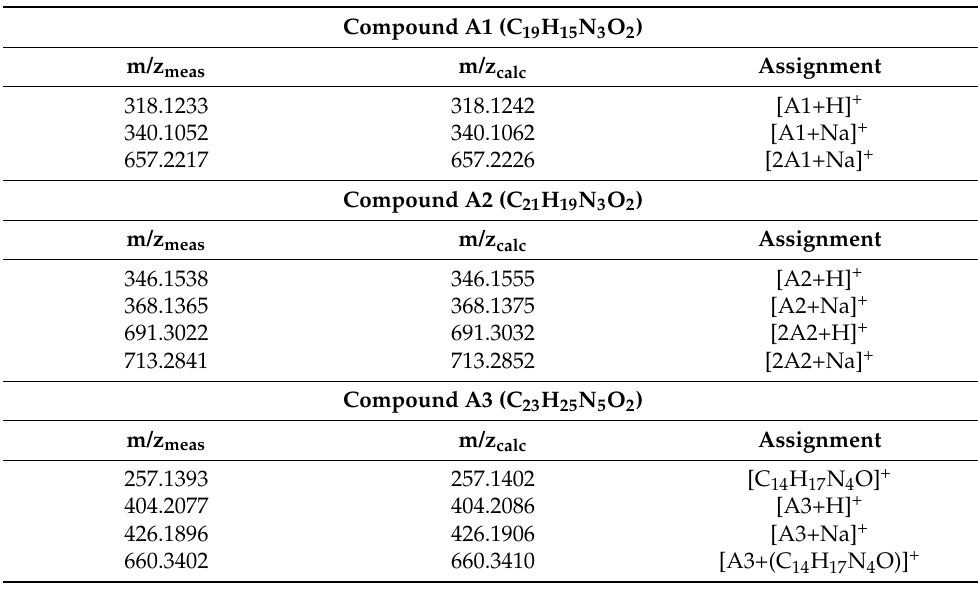
Figure 2. Electrospray ionization (ESI) (+) HRMS mass spectra of compounds: A1 ( a ), A2 ( b ), and A3 ( c ), dissolved in methanol. The unassigned signals correspond to ions, which are not relevant in this study (i.e., complexes formed by solvent molecules, impurities). Table 4. Electrospray ionization high-resolution mass spectrometry (ESI HRMS) data of the main ions found in the samples containing the A1–A3 compounds analyzed, dissolved in